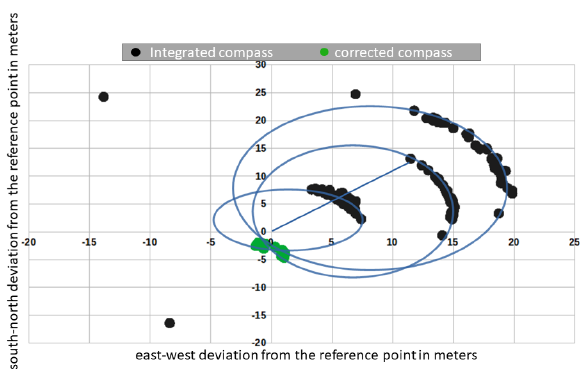
Figure 10. Site: 1, Direction: 1, Distance: 5m/10m/15m, Device: Xiaomi Mi8 The standard deviations of the distance to the reference